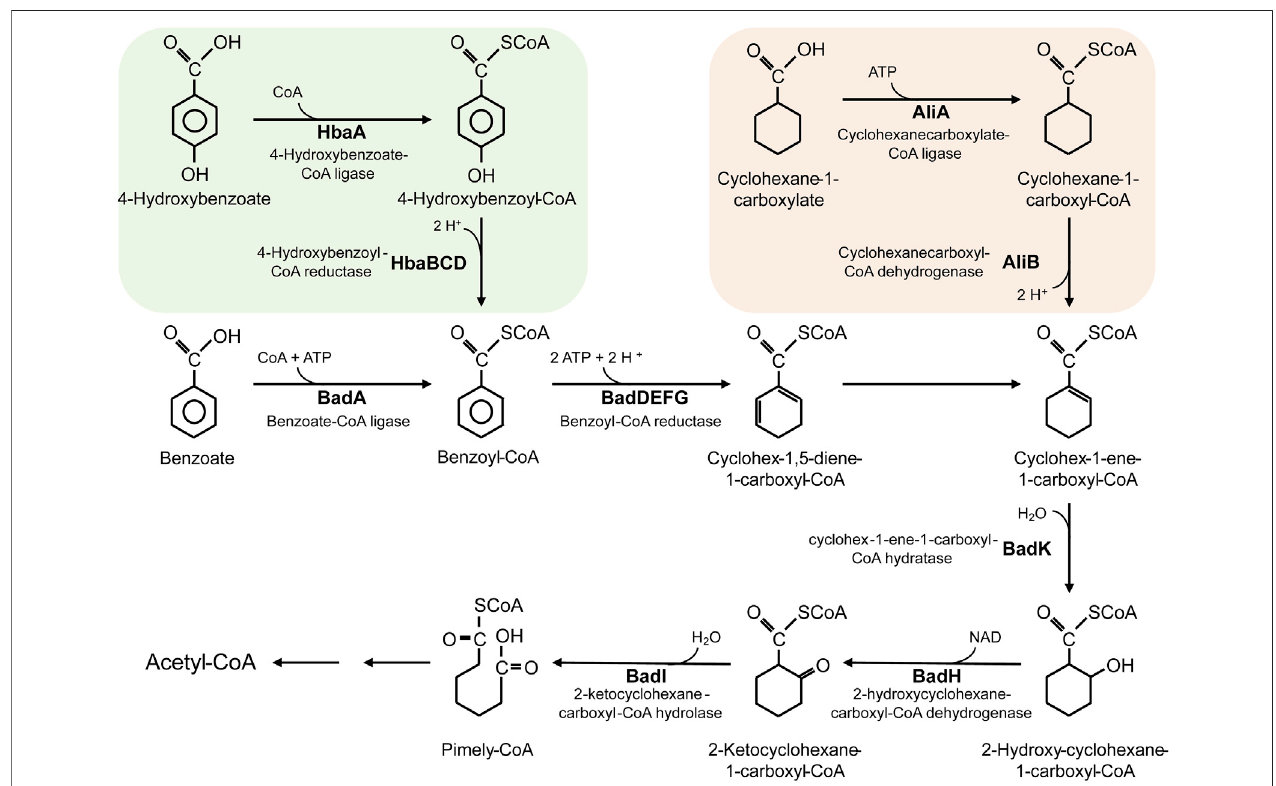
FIGURE 2 | The metabolic pathway for degradation of benzoate, 4-hydroxybenzoate and cyclohexane-1-carboxylate in R. palustris .